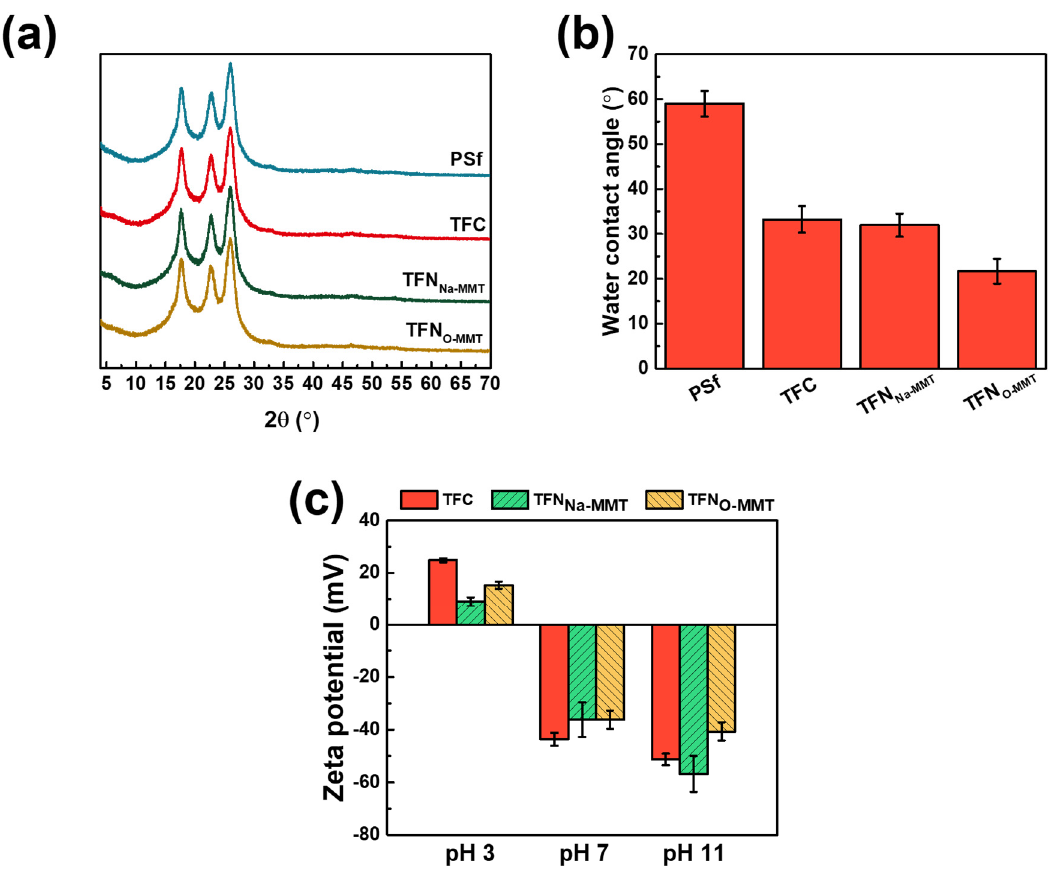
Figure 9. ( a ) XRD analysis; ( b ) water contact angle; and ( c ) zeta potential analysis of the membranes. Particle concentration = 0.05 g O-MMT / g TMC.